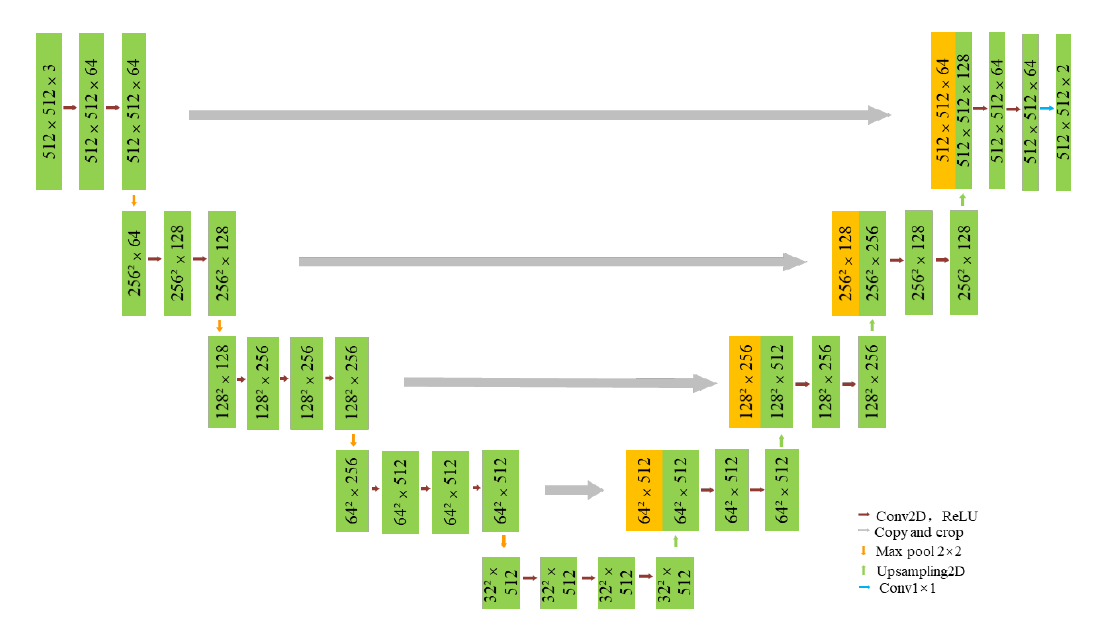
Figure 5. VU-Net structure model.